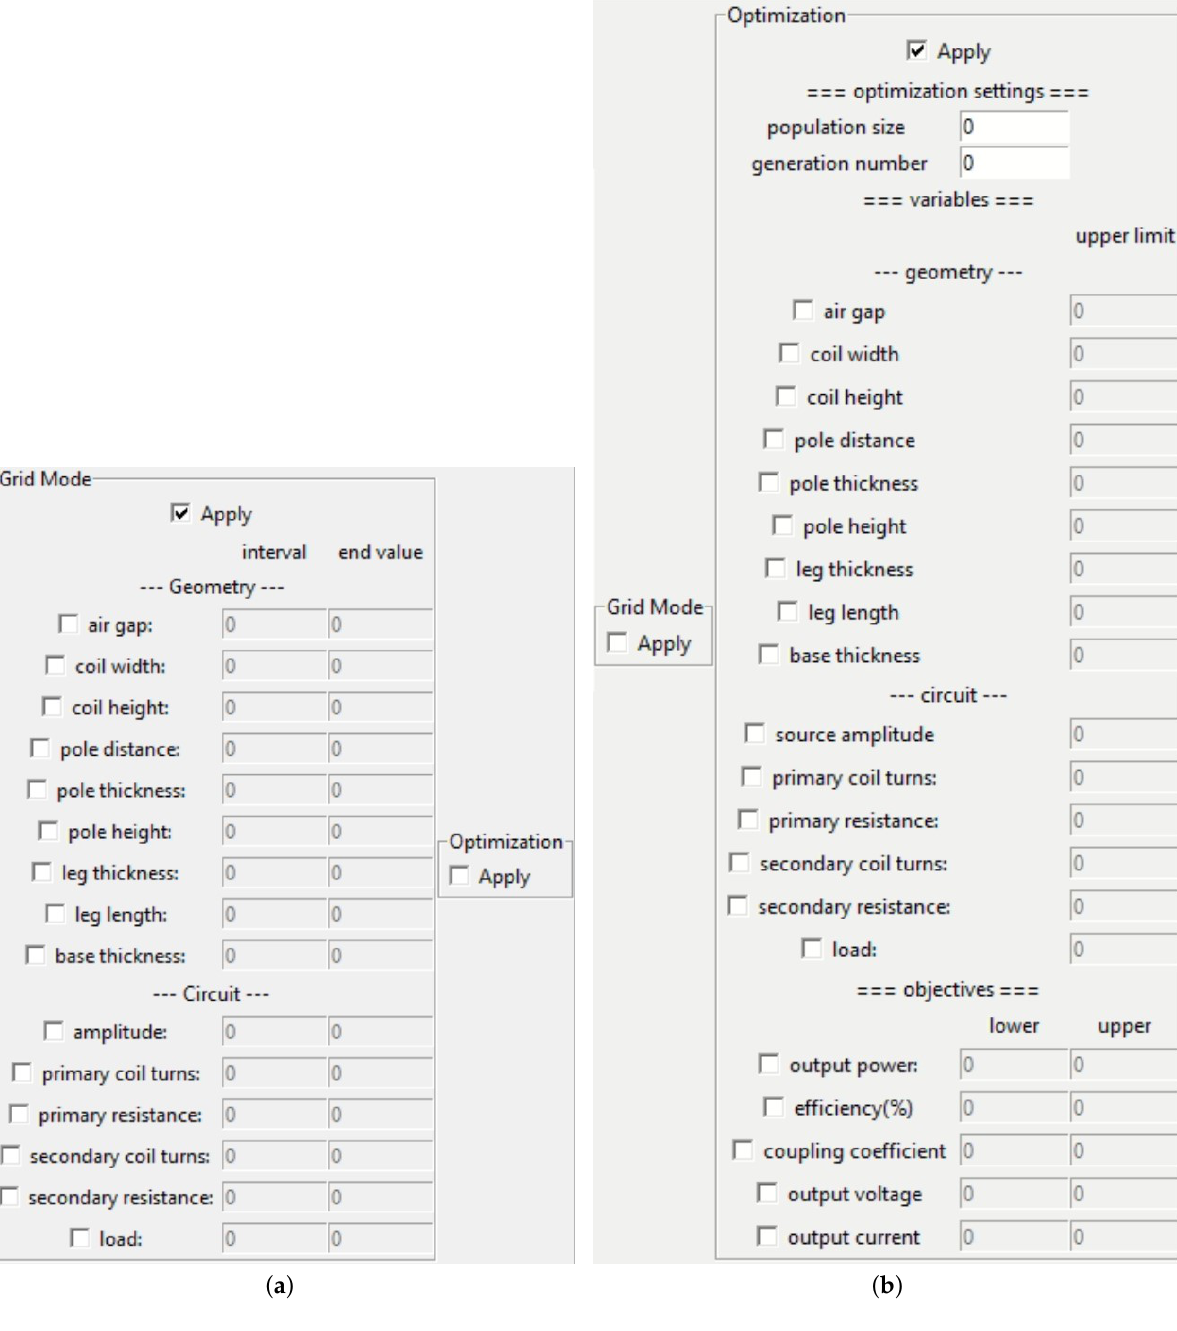
Figure 5. Approaches interface section. ( a ) Grid analysis. ( b )